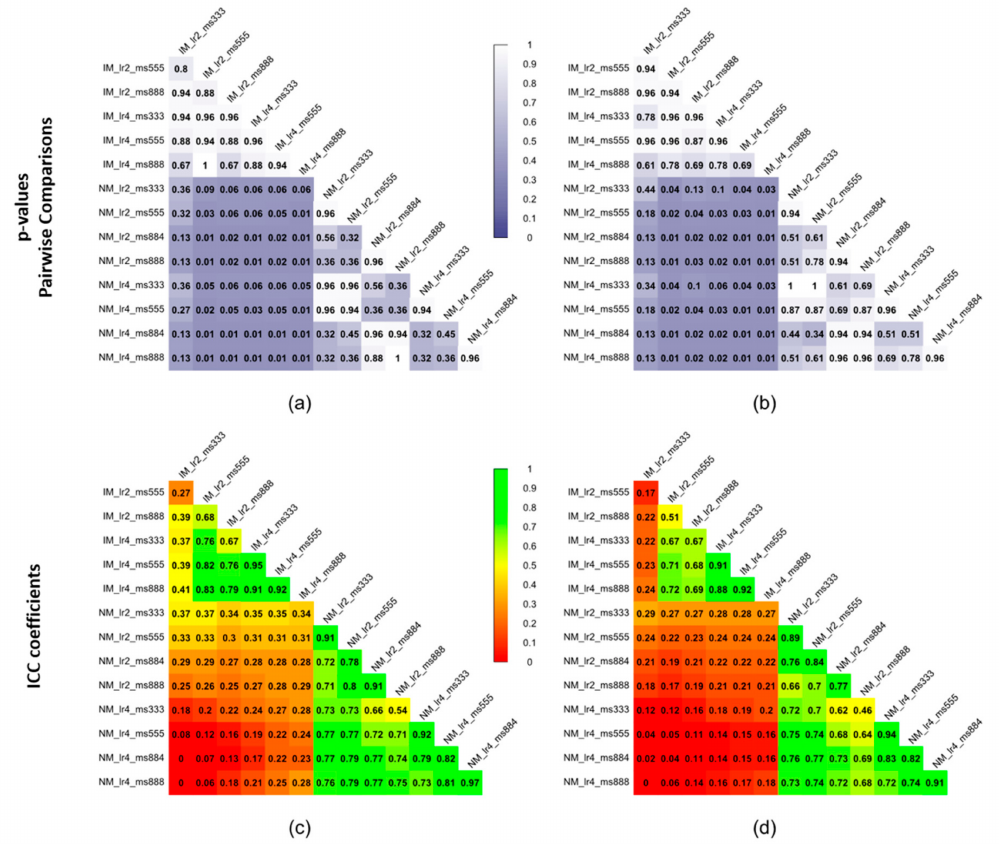
Figure 8. Statistical significance expressed as p-values of pairwise comparisons using the Wilcoxon rank sum test for ( a ) DSI and ( b ) MSD and intraclass correlation coe ffi cients (ICCs) for ( c ) DSI and ( d ) MSD of the non-rigid registration step considering the 4 muscle ROIs